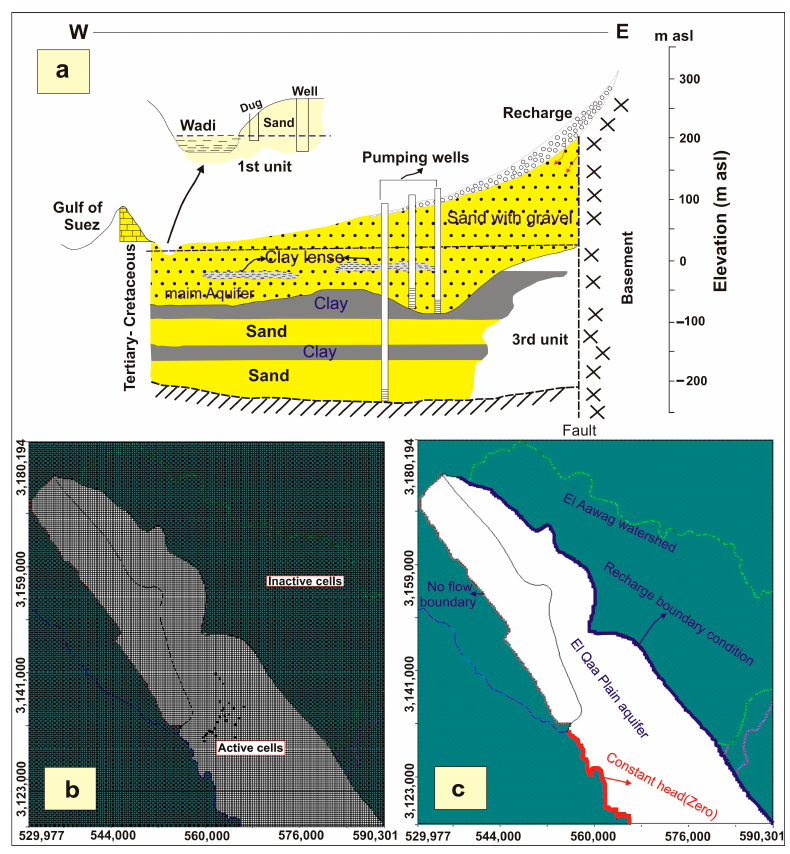
Figure 9. ( a ) Conceptual (schematic) cross-section of El-Qaa Plain (after [32]); ( b ) model grids showing rows, columns, active, and inactive cells; ( c ) model boundary conditions. The model has rectangular dimensions of 60,324 m in width and 65,380 m in height to represent an active aquifer dimension of 66 km (maximum length) and 24 km (maximum width). The number of rows and columns is 200 and 200, respectively (Figure 9b). The active cells represent the investigated aquifer system, which is represented by the Quaternary water-bearing deposits, while the inactive cells represent the impervious boundaries of the eastern basement rocks and the western rocks of Mountain Qabaliat. The 3D grid Software (http://www.ssg-surfer.com/html/surfer_details.html, accessed on 5 May